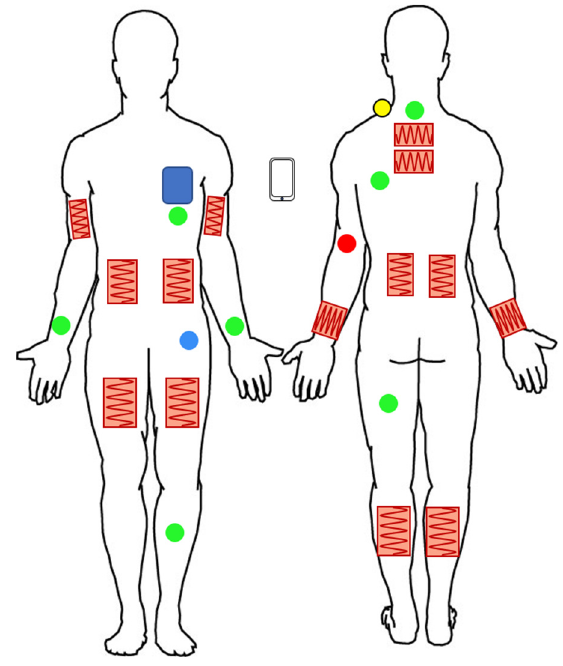
Figure 2. Placement of system components in the suit—left front, right back (red rectangles—heating insets; blue rectangle—embedded system; green circles—undergarment temperature sensors; blue circle—acc/gyro sensor; red circle—external temperature sensor; yellow circle—luminance sensor).